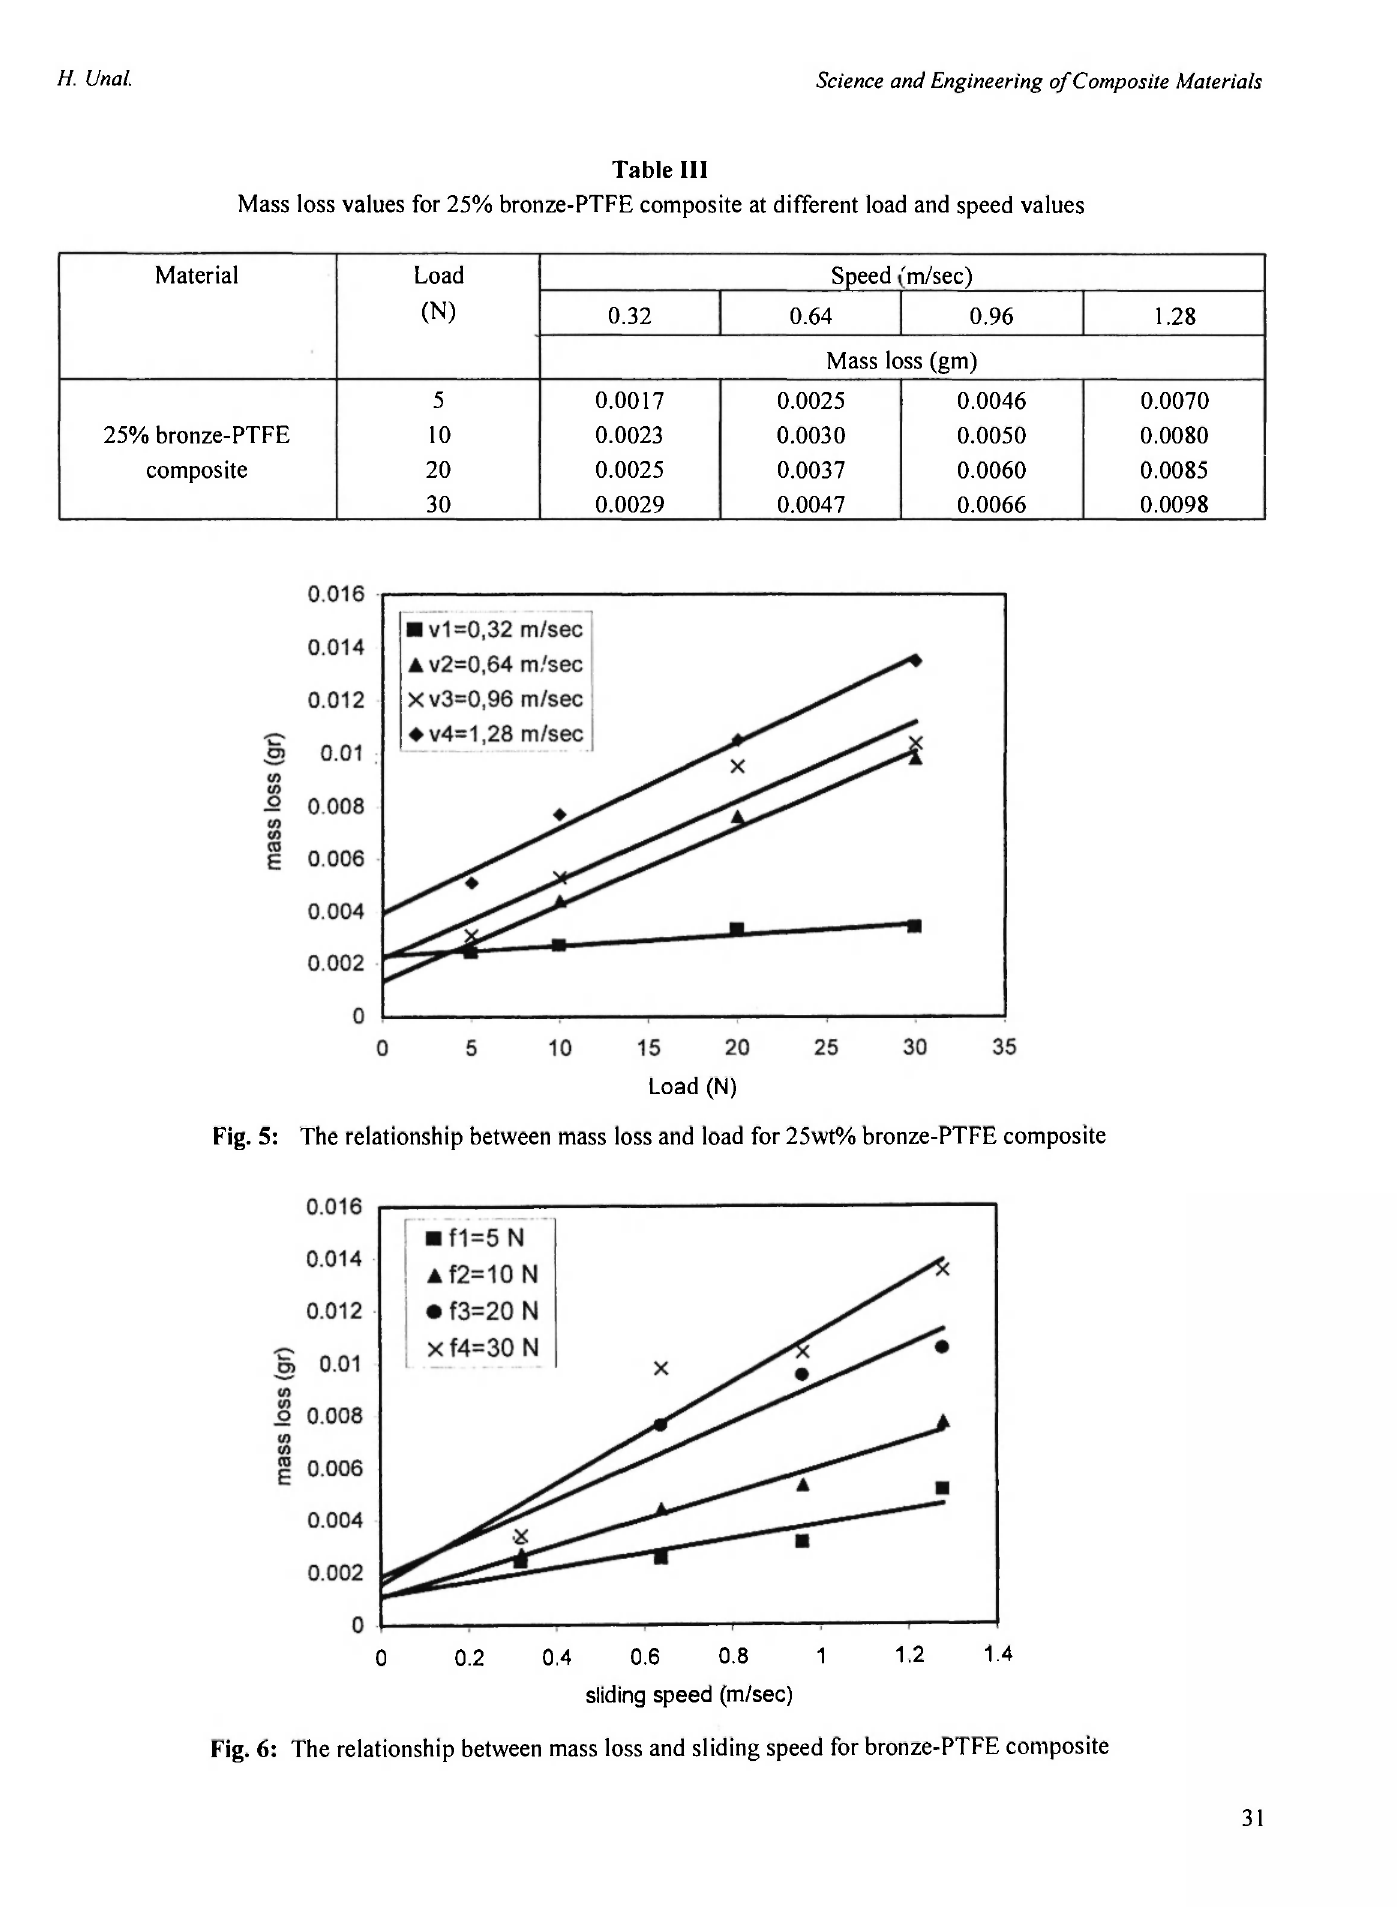
Fig. 6: The relationship between mass loss and sliding speed for bronze-PTFE